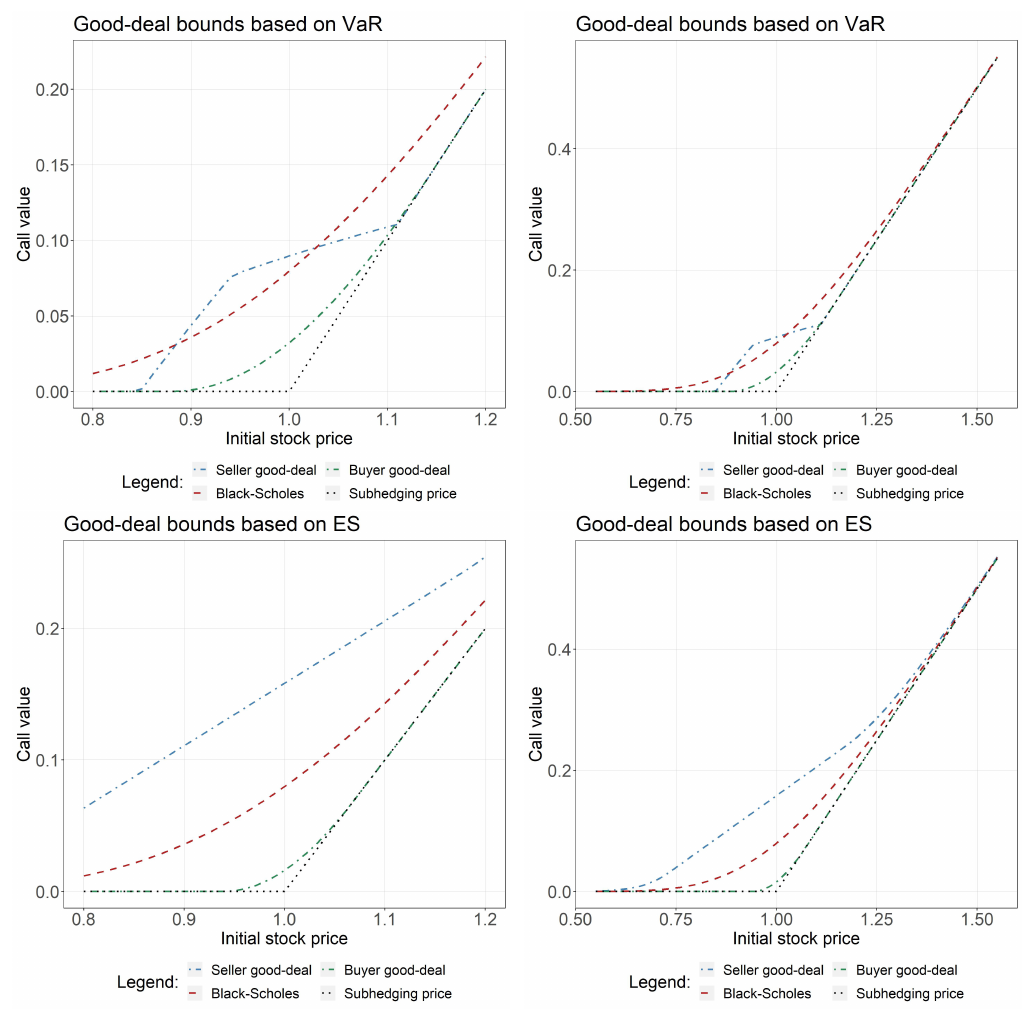
Figure 3. Good-deal bounds depending on the stock